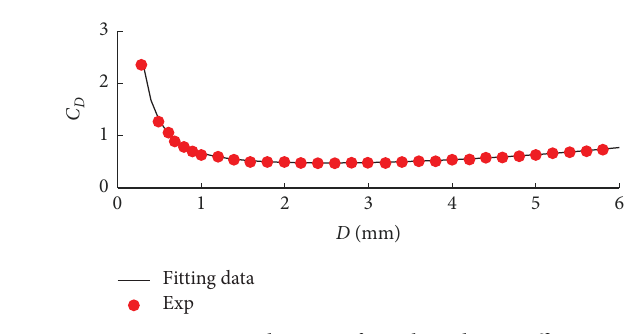
Figure 11: Fitting diagram of raindrop drag coefcient.